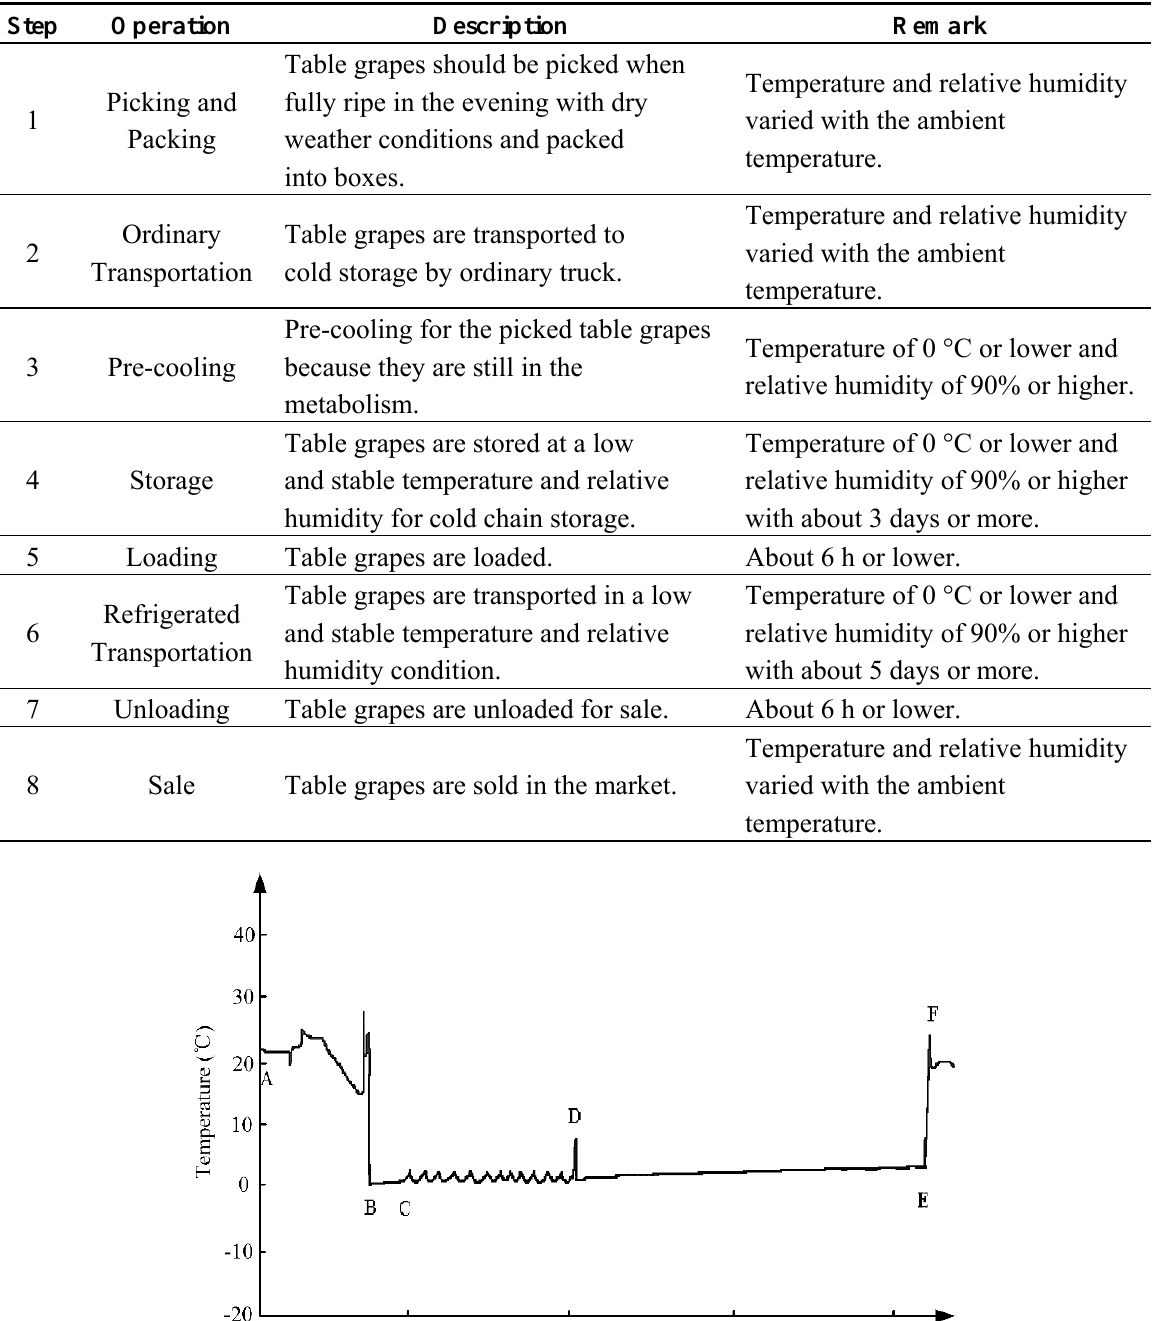
Table 1. Cold chain logistics process of table grapes.